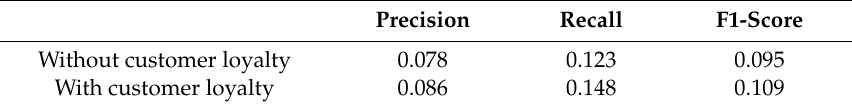
Table 4. Recommendation effect of PersonalRank with and without customer loyalty.